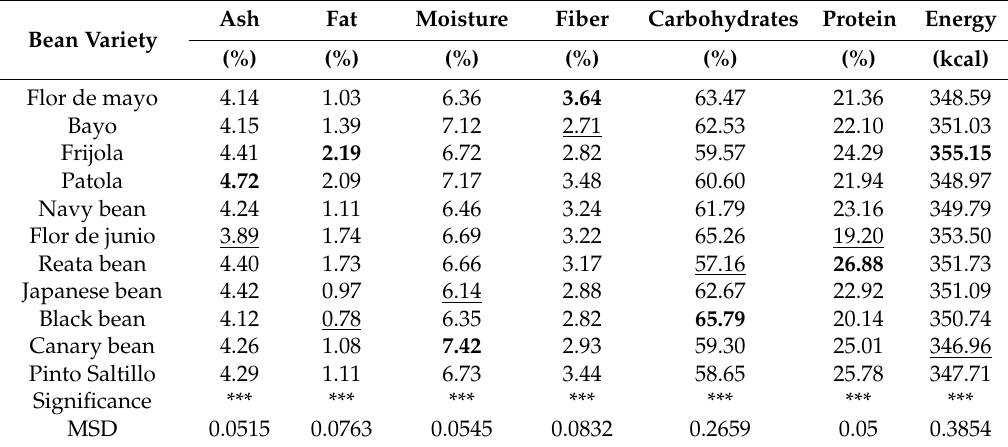
Table 4. Physico-chemical composition of the different bean varieties grown and consumed in the state of Zacatecas,